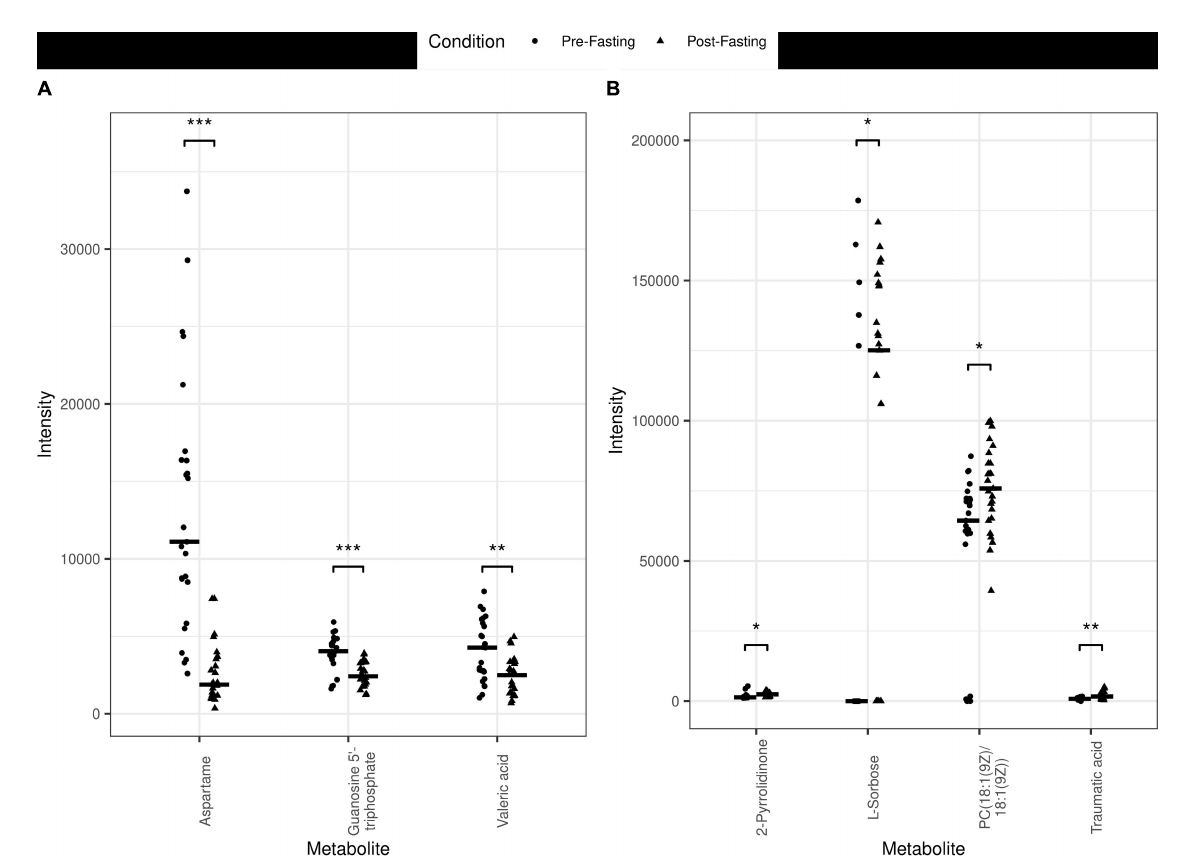
FIGURE3 Jitter plots of the metabolites measured in the different plasma samples pre- vs. post-fasting. (A) Examples of metabolites that decreased with fasting are Aspartame ( P < 0.001, ***), Guanosine 5 (cid:48) -triphosphate ( P < 0.001, ***), and Valeric acid ( P < 0.01, **). (B) Examples of metabolites that increased with fasting include 2-Pyrrolidinone ( P < 0.05, *), L-Sorbose ( P < 0.05, *), PC[18:1(9Z)/18:1(9Z)] ( P < 0.05, *) and Traumatic acid ( P < 0.01) (**).